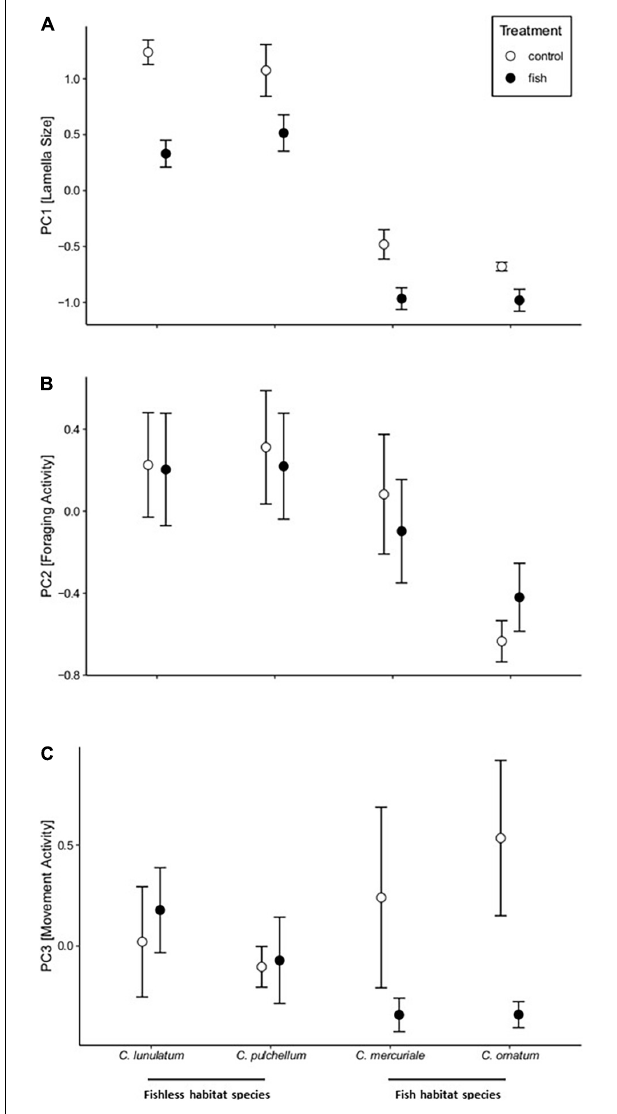
FIGURE 2 | Differences in (A) PC1: Lamella Size, (B) PC2: Foraging Activity, and (C) PC3: Movement Activity between larval damselflies of fishless habitat species ( Coenagrion lunulatum and Coenagrion pulchellum ) and fish habitat species ( Coenagrion mercuriale and Coenagrion ornatum ) that were either raised with predatory fish (black circles) or in a control treatment (white circles). Error bars correspond to standard errors.